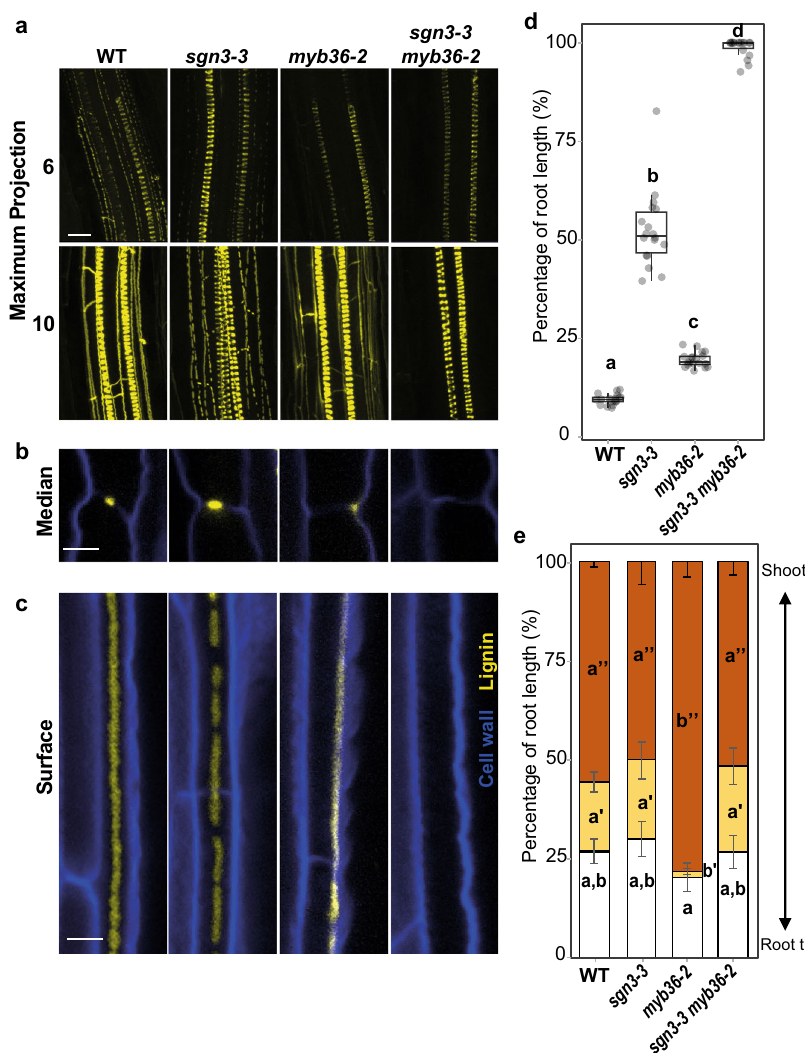
Fig. 1 Disruption of MYB36 and SGN3 abolishes endodermal ligni fi cation and root apoplastic barrier. a Maximum projection of lignin staining at the sixth and tenth endodermal cell after the onset of elongation. Spiral structures in the centre of the root are xylem. Scale bar = 10 µ m. Median ( b ) and surface ( c ) view of an endodermal cell at ten cells after the onset of elongation. Scale bar = 5 µ m. The roots were cleared and stained with basic fuchsin (yellow) for lignin and with Calco fl uor white (blue) for cellulose. The experiment was repeated three times independently with similar results. d Boxplot showing the percentage of the root length permeable to propidium iodide. n = 18 from two independent experiments. Different letters represent signi fi cant differences between genotypes using a two-sided Mann – Whitney test ( p < 0.01). Centre lines show the medians; box limits indicate the 25th and 75th percentiles. e Quanti fi cation of suberin staining along the root. The results are expressed in percentage of root length divided in three zones: unsuberized (white), discontinuously suberized (yellow), continuously suberized (orange). n = 5 plants for WT, n = 6 plants for sgn3-3 , n = 7 plants for myb36-2 and n = 7 plants for sgn3-3 myb36-2 , error bars: SD, the centre of the error bars represents the mean. Individual letters show signi fi cant differences using a two-sided Mann – Whitney test between the same zones ( p < 0.01). The experiment was repeated two times independently with similar